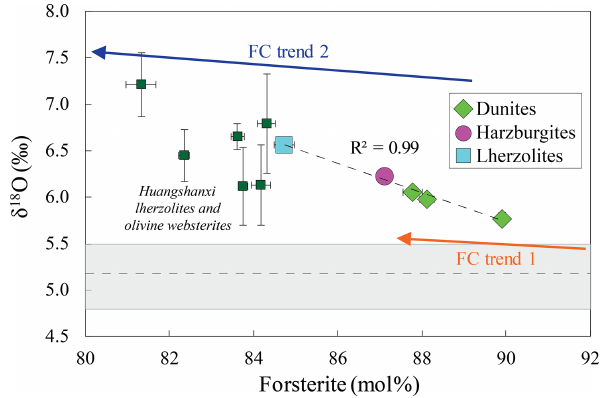
Figure 10. δ 18 O (weighted average ± 2 σ ) versus forsterite pro- portion (mean ± 2 σ ) of olivine from the Rocca d’Argimonia peri- dotites; the error bars are in most cases within the symbol area. The compositions of olivine from lherzolites and olivine websterites of the Huangshanxi mafic-ultramafic intrusion in northwestern China (Mao et al., 2019) are reported for comparative purposes. The grey field represents the δ 18 O of typical mantle olivines (Mattey et al., 1994). The diagram also reports the δ 18 O variations modelled by Bucholz et al. (2017) in response to closed system fractional crys- tallization for (i) an anhydrous tholeiite crystallizing at 1.0GPa (FC trend 1) and (ii) a high-K basalt with 2.5 H 2 O crystallizing at ∼ 0.4GPa (FC trend 2). The anhydrous tholeiite model is based on the experimental results of Villiger et al. (2004); a typical man- tle δ 18 O value of + 5.7‰ is assumed for the parental melt. Both models show that the δ 18 O Ol variations observed for the Rocca d’Argimonia peridotites are wider than those dictated by fractional crystallization